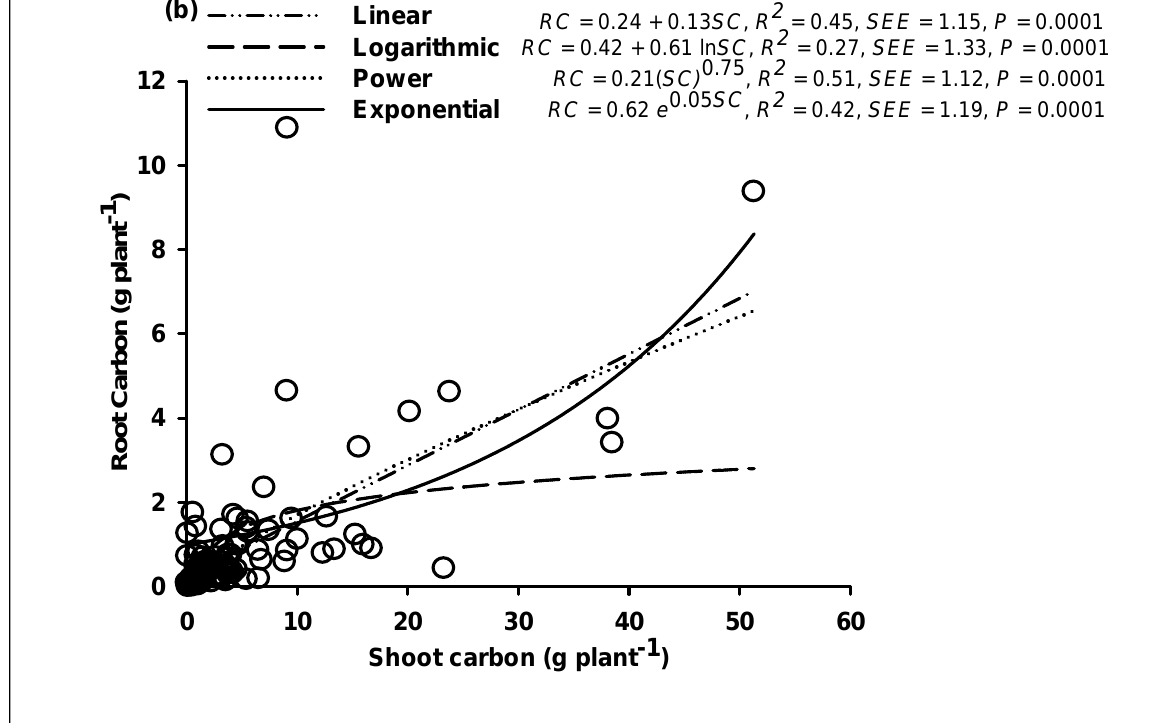
Figure 2: Linear and non-linear relationships (a) between shoot biomass; SB ( X- axis) and root biomass; RB ( Y- axis), and (b) between shoot carbon; SC ( X- axis) and root carbon; RC ( Y- axis) based on 117 herbaceous species in the tropical grassland at Varanasi, India. R 2 =Determination coefficient, SEE = Standard Error of Estimate, P = level of